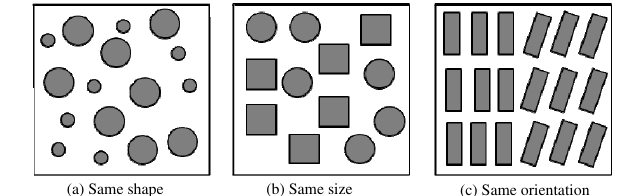
Fig. 5. Law of similarity.